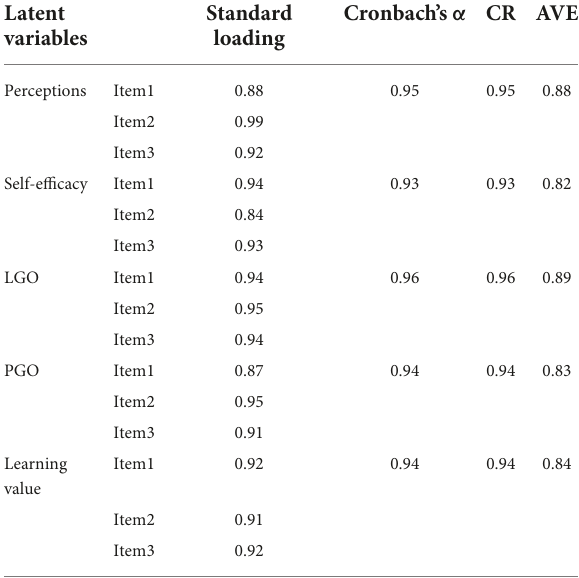
TABLE 2 Results of reliability and convergent validity analyses.